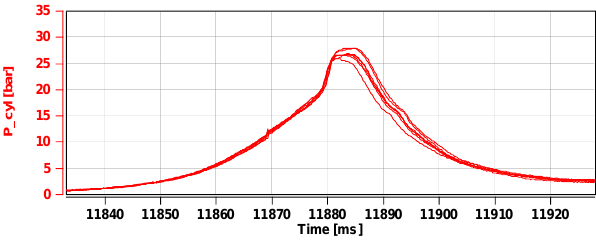
Fig. 5. Cylinder pressure curves indicating the non-repeatability of the work cycles